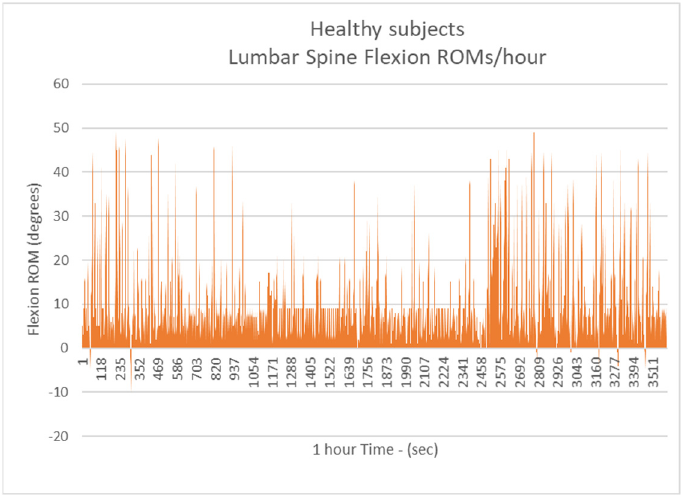
Figure 4. The number of more than 10 degrees of Lumbar Spine Flexions (LSFs) per hour for healthy subjects.